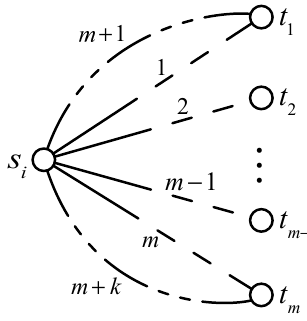
Figure 5. Topology configuration with the highest reliability ( m shortest paths, k redundant